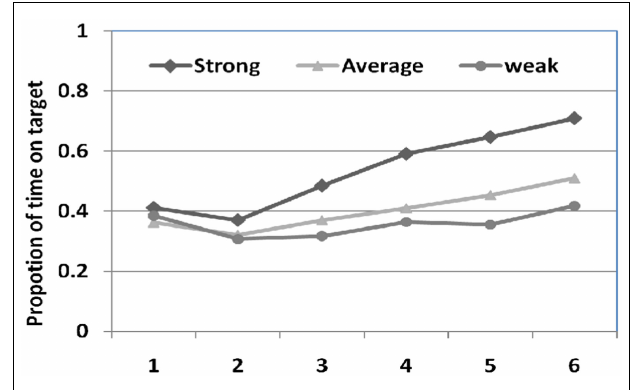
FIGURE 4 |The proportion of time on target after hearing a word. Strong learners looked more and more toward correct objects in the course of statistical learning while average learners showed the similar trend. However, weak learners did not show any linear